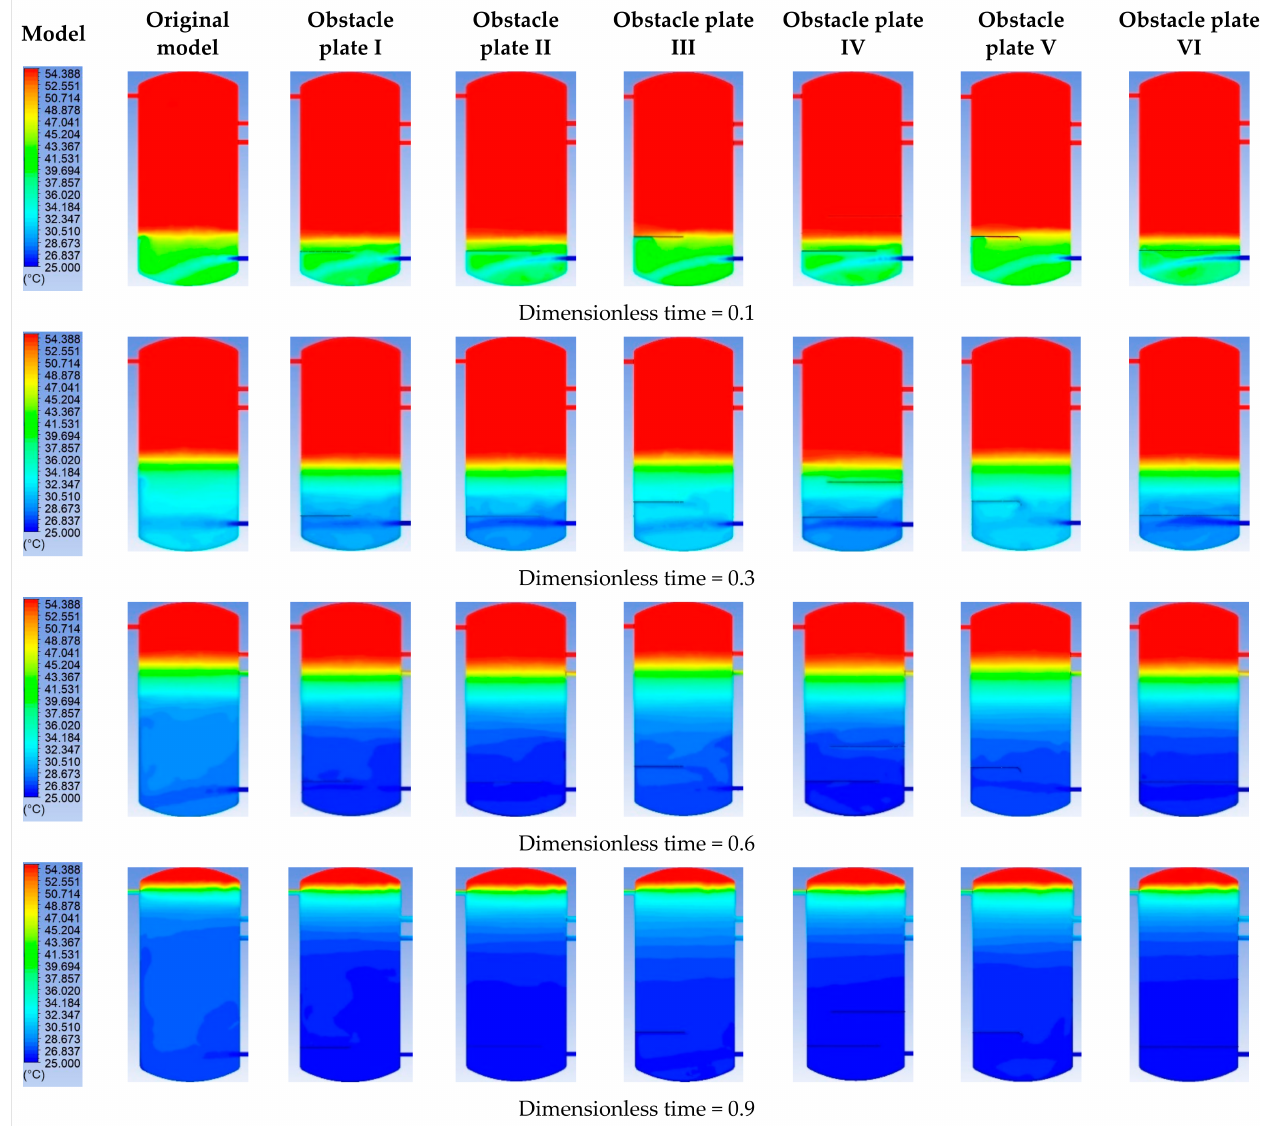
Figure 21. The temperature contours of obstacle plate models.